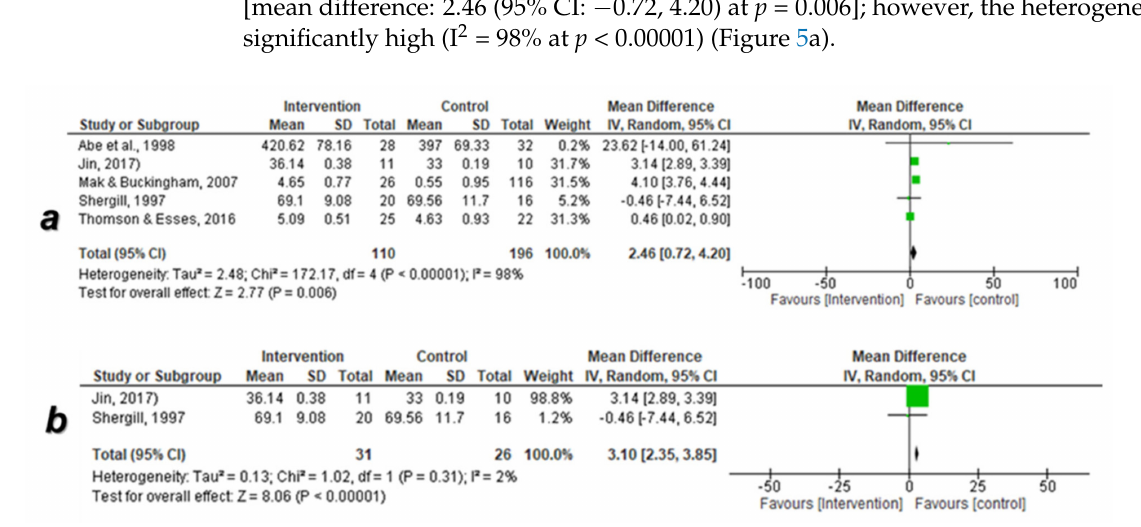
Figure 5. Forest plot of the meta-analysis of the data of adjustment. ( a ) Before application of sensitivity test, ( b ) after application of sensitivity test. I 2 : heterogeneity, CI: confidence interval, SD: standard deviation, P: p -value. Black diamond denotes the overall effect size, green color denotes the central point of the confidence interval. The RCT by Tavakoli et al. (2009) [48] was subdivided into three studies (Tavakoli et al., 2009a, 2009b and 2009c) because it contains three different interventions (assertive training, expressive writing, and a combination of the two methods) versus the same con-troll